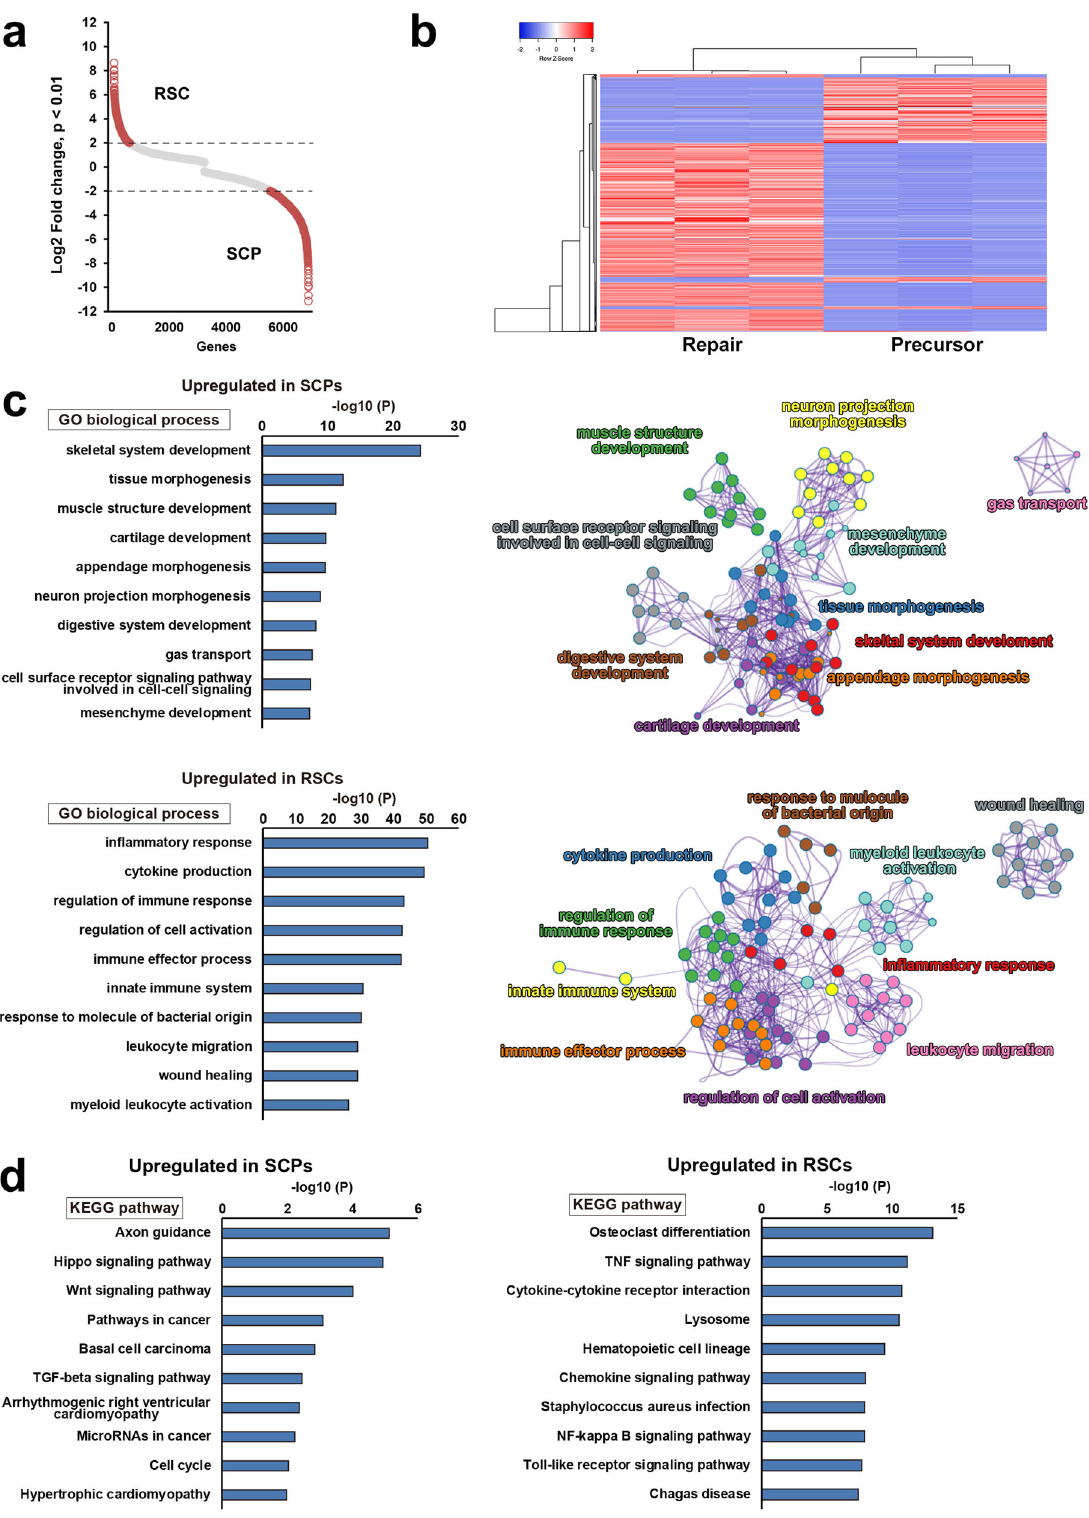
Fig. 6 Transcriptome analysis of RSCs and SCPs. a Scatter plot analysis for transcript expression levels of signi fi cantly upregulated or downregulated genes in RSCs and SCPs. Red circles indicate genes with Log2 fold change over 2 or under − 2. Transcript expression levels were signi fi cantly different in 6804 genes ( p < 0.01), and 1933 genes were more than 4-folds changed ( p < 0.01, log2FC > 2). b Heatmap of gene expressions in RSCs and SCPS. They revealed a high degree of similarity between the samples in each group, and gene expression pro fi les are distinctly different between RSC and SCPs. Red and blue indicate the highest and lowest relative levels of gene expression. c Top ten enriched GO terms of biological process and their cluster visualization in SCPs (upper row) and RSCs (lower row). Development-related terms are upregulated in SCPs, whereas in fl ammation-related terms are upregulated in RSCs. Cluster annotations are shown in each clusters ’ color. d KEGG pathway analysis in SCPs (left) and RSCs (right). Biological terms are distinctly different between these two